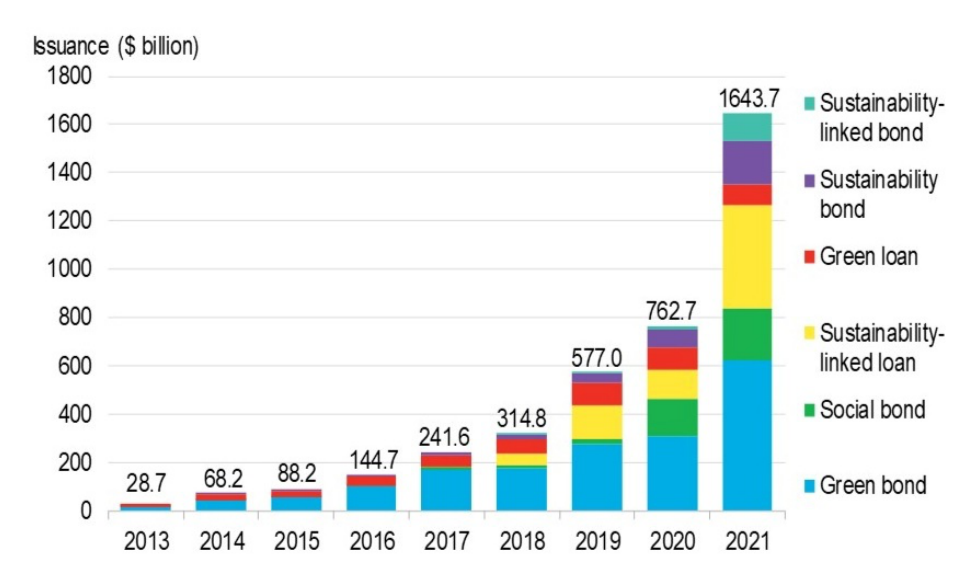
Figure A5. Sustainable Debt Bloomberg : Source: